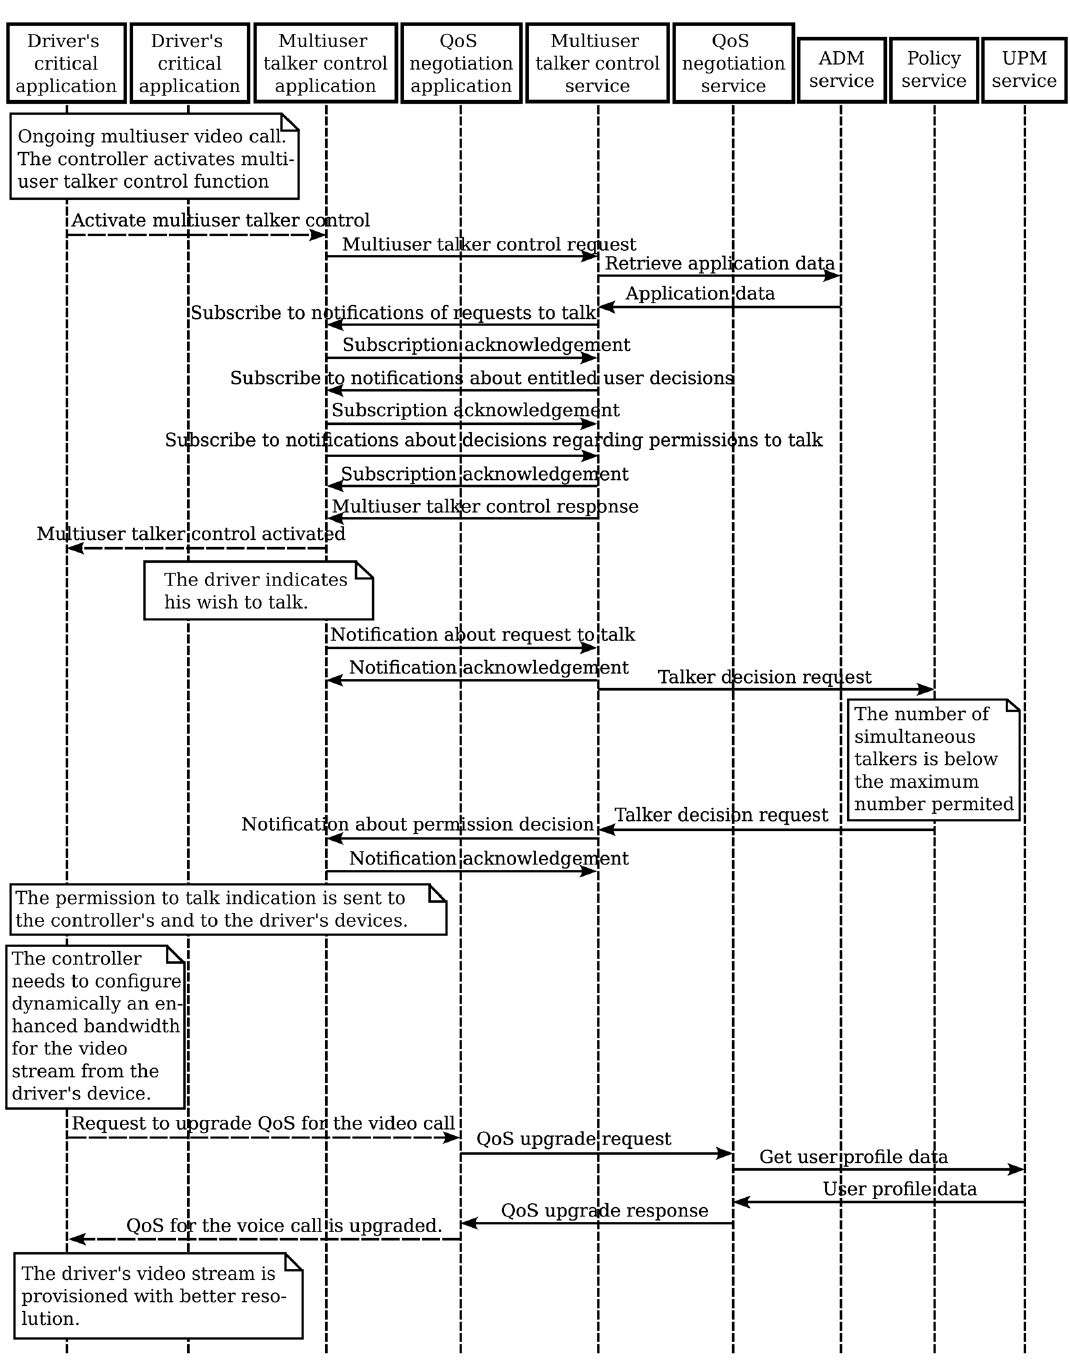
Figure 13. Services interaction flow for multiuser talker control and QoS class negotiation.